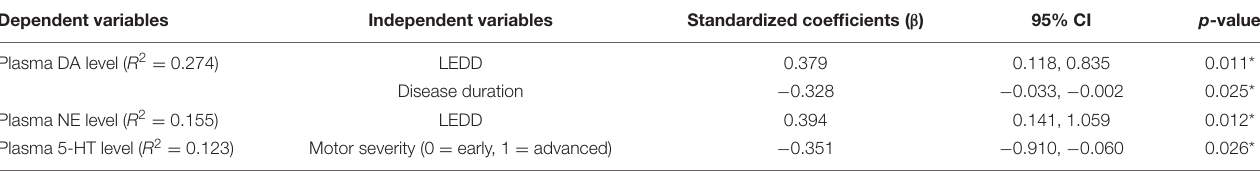
TABLE 3 | Multiple linear regression model for the association between plasma monoamine levels and clinical profiles of PD patients. Dependent variables Independent variables Standardized coefficients ( β ) 95% CI p -value Plasma DA level ( R 2 =